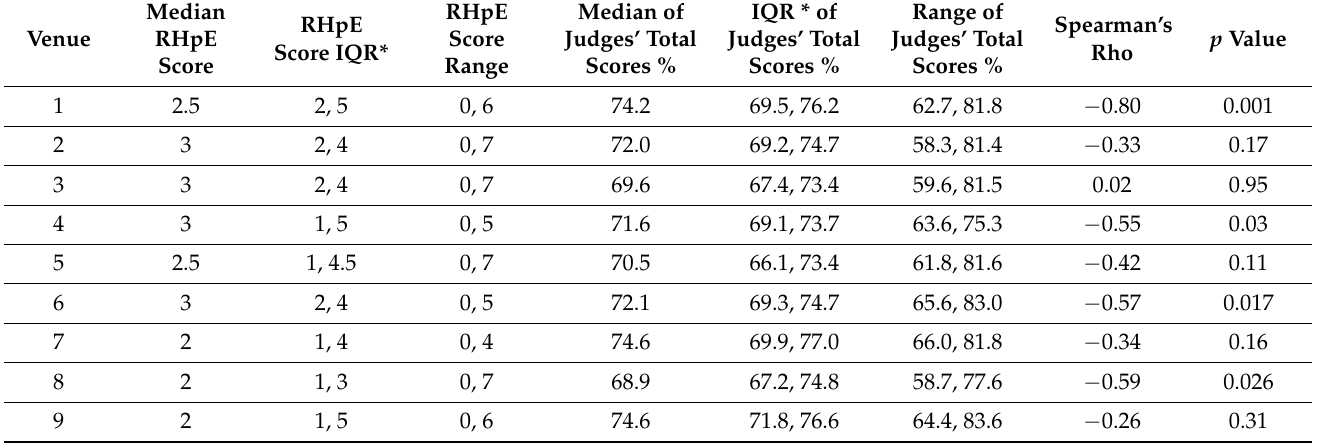
Table 3. The relationship between the judges’ final total percentage score and the Ridden Horse Pain Ethogram (RHpE) score (0–24) assessed using Spearman’s correlation for horses ( n = 147) competing at nine venues at World Cup Grand Prix dressage Western European qualifying competitions ( n = 7; venues 1, 3–6, 8, 9) and two World Cup Grand Prix dressage finals (venues 2 and 7), 2018–2020. Significant negative correlations are highlighted in